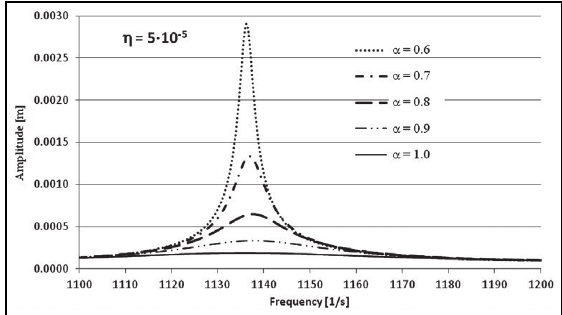
Fig. 8. Amplitude-frequency characteristic – 2-nd resonance. Fig. 9. Amplitude-frequency characteristic – 3-th resonance.